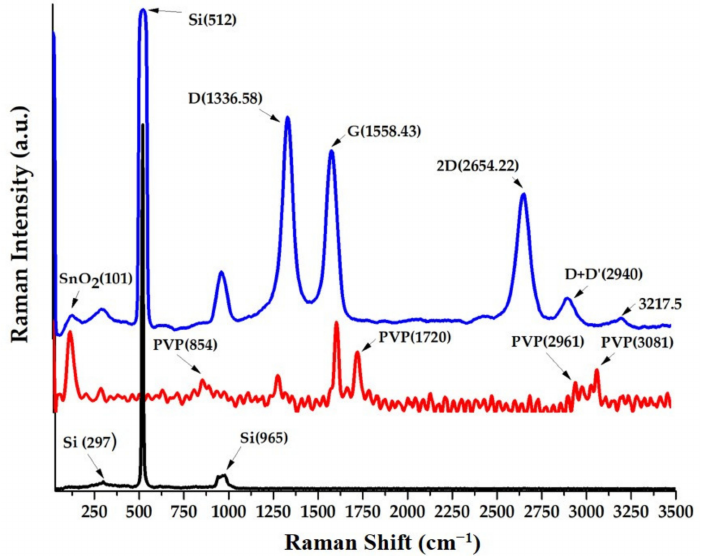
Figure 1. Ramanspectraofsolid-statefilmsofsinglewalledcarbonnanohorns-SnO 2 -polyvinylpyrrolidone (SWCNH / SnO 2 / PVP) = 1 / 1 / 1 (mass ratio) deposited on silicon